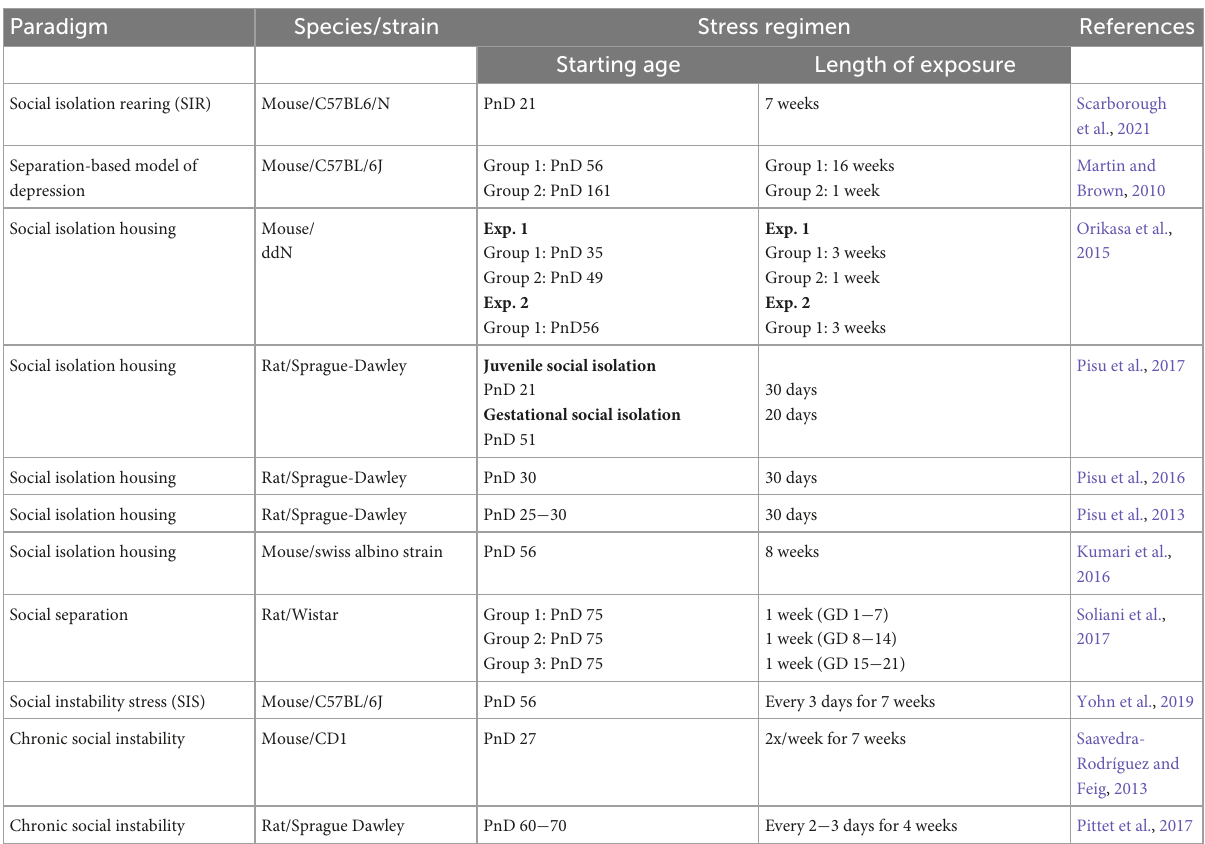
TABLE 3 Rodent social stress